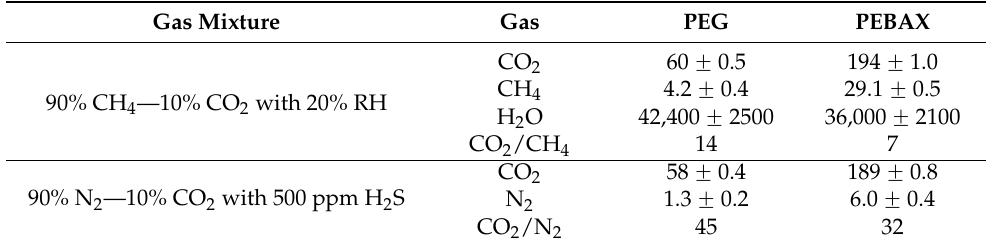
Table 4. Gas permeability (Barrer) through PEG and PEBAX membranes under different mixed gas conditions at 35 ˝